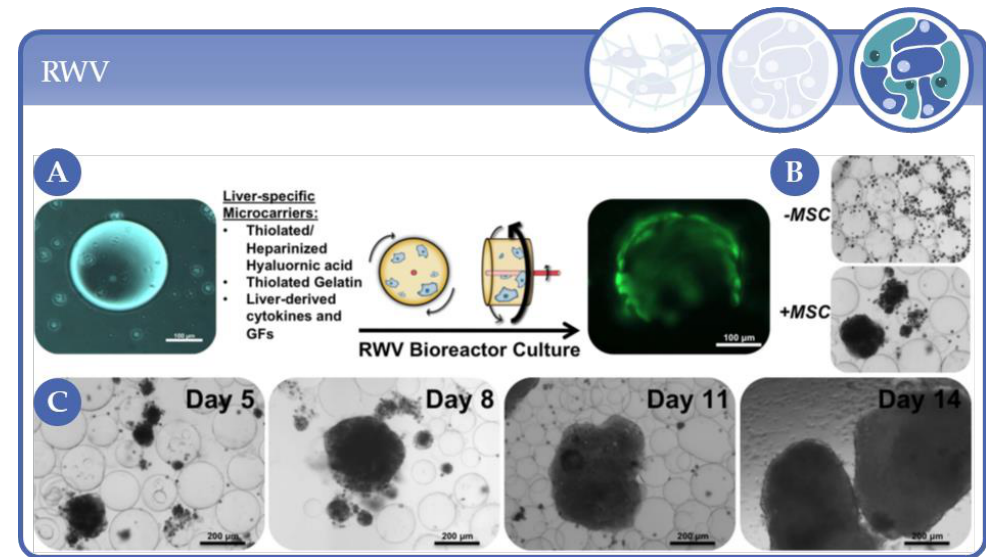
Figure 19. Colon carcinoma cell growth inside liver tumor organoids. ( A ) Scheme of liver tumor organoid formation in an RWV bioreactor. ( B ) MSCs supporting organoid formation. ( C ) Formation of liver tumor organoids including MSCs. Reproduced from [180] with permission ® IOP Publishing. All rights reserved.